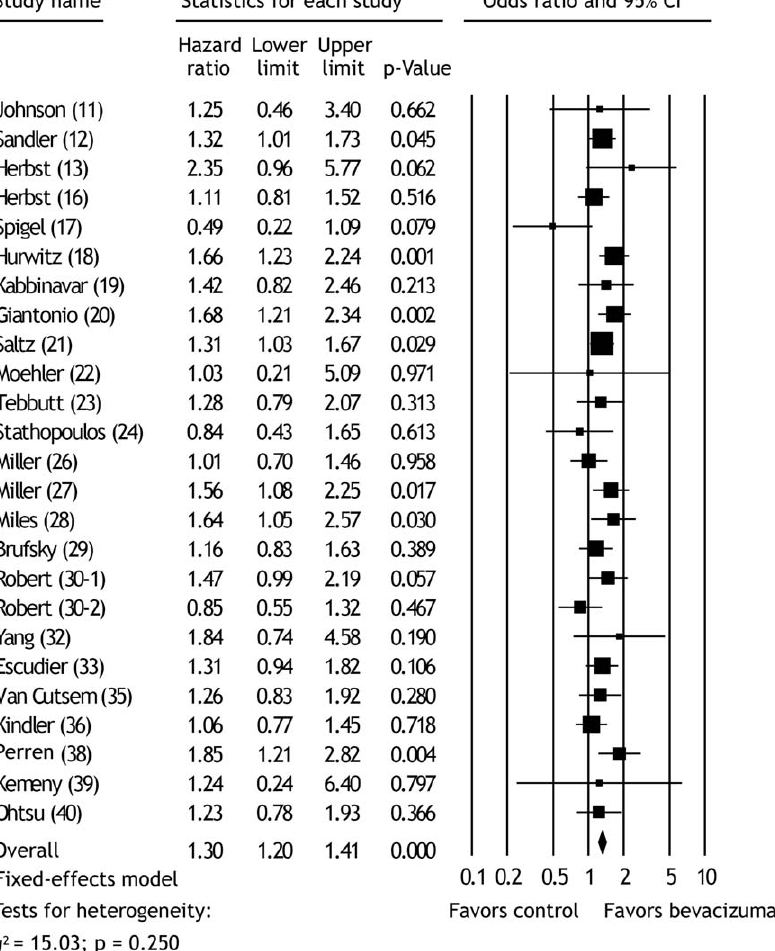
Table S1 Characteristics of the trials included in this meta-analysis.